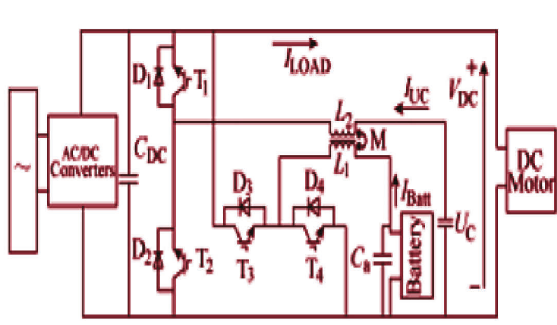
Figure 2: Topology of the hybrid energy storage